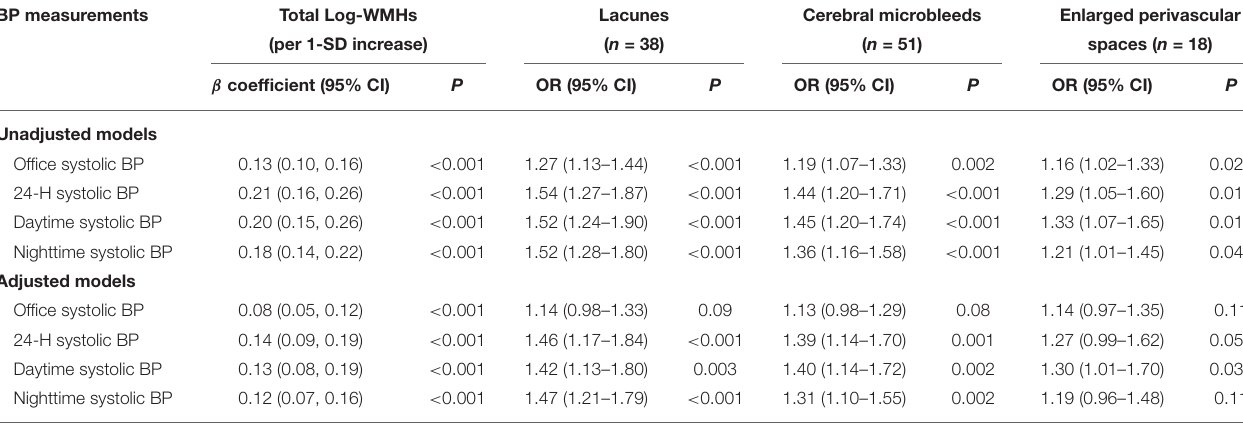
TABLE 2 | Association of quantitative and categorical subclinical markers of cerebral small vessel disease with office and ambulatory blood pressure measurements. BP